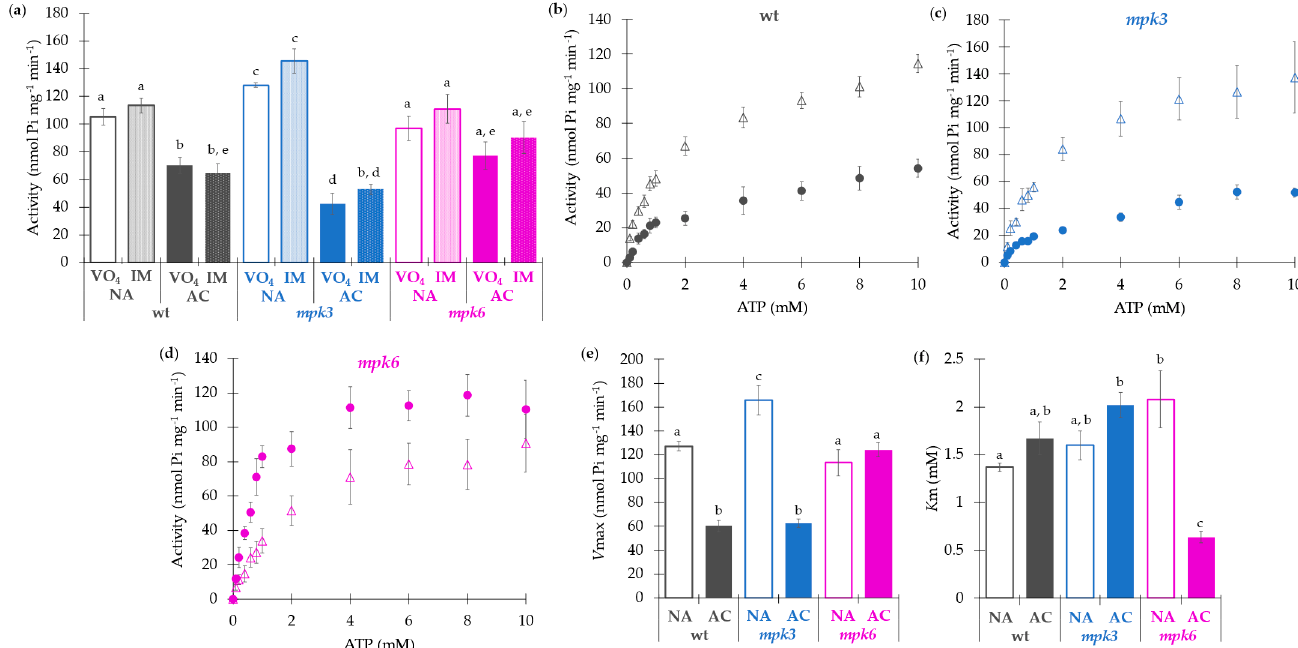
Figure 2. Effect of cold acclimation on the activity and kinetics of the plasma membrane H + -ATPase from wild type, mpk3, and mpk6 plants. ( a ) Plasma membrane H + -ATPase activity from wild type, mpk3, and mpk6 plants exposed to NA or AC conditions. PMV isolated from NA and AC wild type, mpk3, and mpk6 plants were used to measure ATP hydrolysis in the presence of the specific inhibitor (VO 43 − ) or the specific inhibitors (IM; NO 3 − 1 , N 3 − 1 , and MoO 4 − 2 ) of some possible contaminant enzymes. ATPase activity was measured at 10 mM of ATP-Mg. ( b – d ) Kinetic profiling of the plasma membrane H + -ATPase activity from the NA plants (empty circles), or AC plants (solid circles). ( b ) Kinetics of the plasma membrane H + -ATPase activity from wild type plants. ( c ) mpk3 plants. ( d ) mpk6 plants. ( e ) V max values calculated from the panels ( b – d ). ( f ) K m values calculated from the panels ( b – d ). Values of the kinetic constants and Hill numbers are presented in Table S1. Plasma membrane H + -ATPase activity was measured from Pi released from ATP. Substrate concentrations were varied between 0.1 to 10 mM ATP-Mg. Values presented in panel ( a ) are the mean values of six biological replicates ± SE. α ≤ 0.05 (ANOVA test). Significant differences are indicated by different letters. Values presented in panels ( b – f ) are means of four biological replicates ± SE. α ≤ 0.05 (ANOVA test). Significant differences are indicated by different letters.